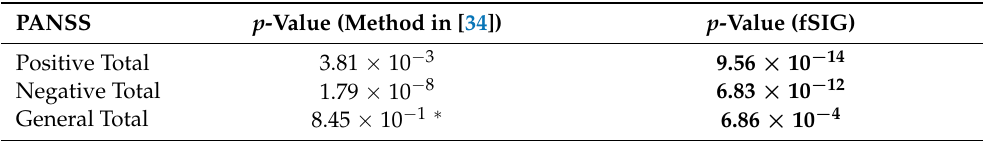
Table 4. Two-sample t -test of the positive, negative, and general symptoms in PANSS (lower p -Value is marked in bold and non-significant values are marked with ∗